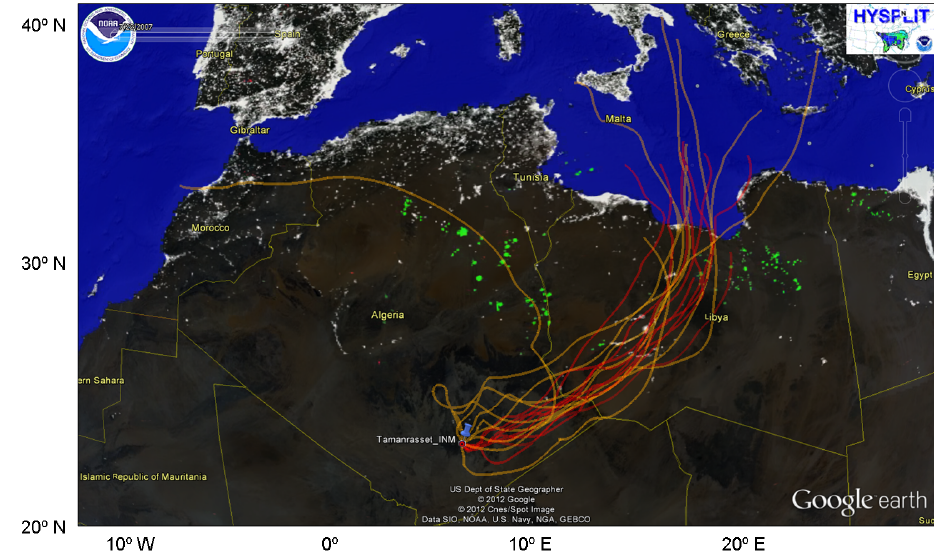
Figure 13. HYSPLIT back trajectories arriving at Tamanrasset (blue pin) at ground level (red lines) and 2600ma.g.l. (yellow lines) are displayed for several case studies. DMSP night-time lights (shown as background) identify gas flares (green